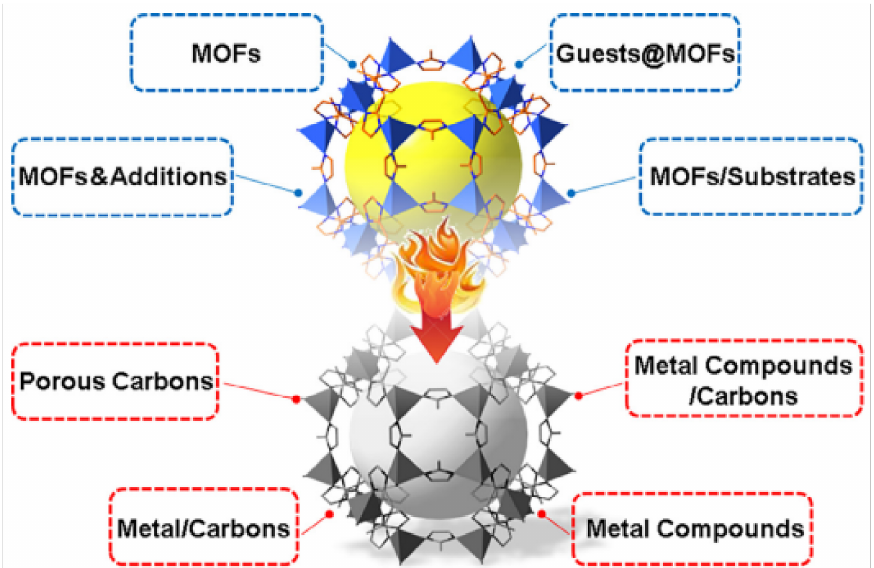
Figure 3. Classes of MOF-derived carbons. Reproduced from ref. [63]. Copyright © (2018) with permission from